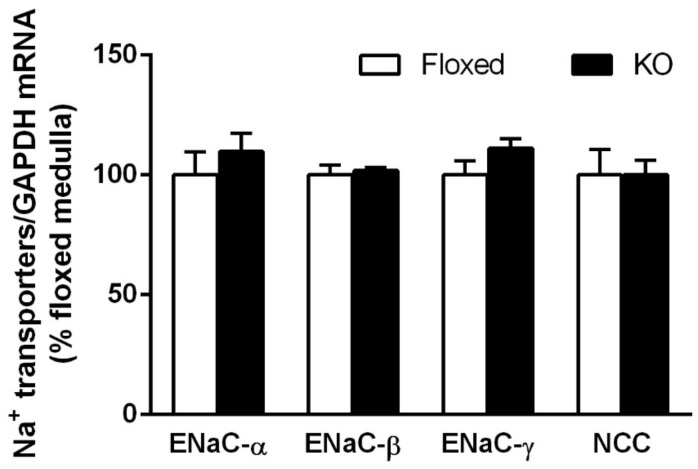
Na+ transporter mRNA levels in floxed and CD renin KO mice after 17-days of DOCA-salt treatment.ENaC—epithelial Na+ channel, NCC—NaCl cotransporter (N = 4/group).